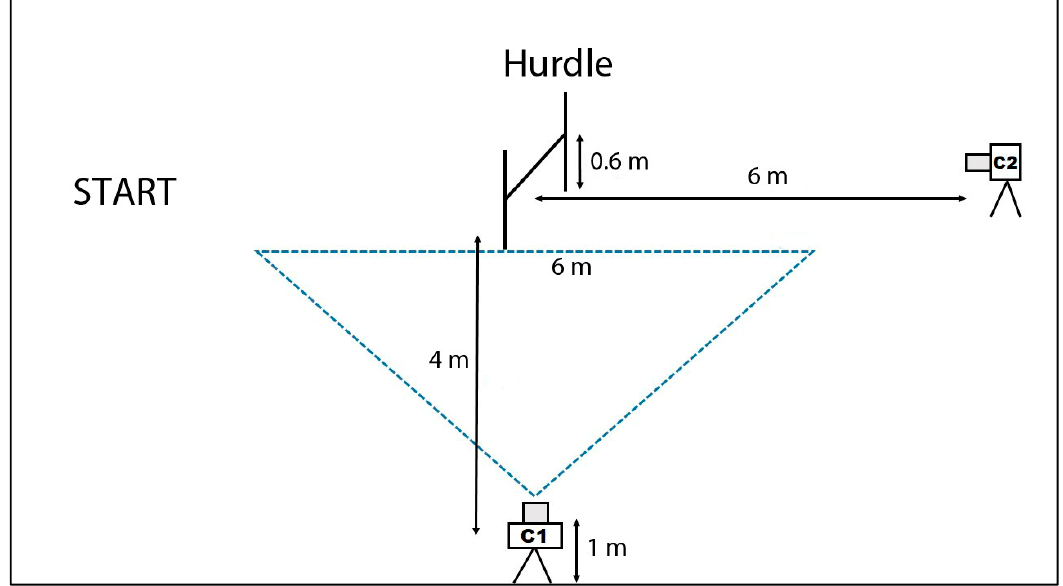
Figure 1. Schematic representation of the layout of the hurdle, cameras, and field of view of camera 1 used in the study. Dogs started to run from the start point towards the hurdle at their handler´s command. C1, camera for data collection. C2, camera for checking the validity of trials.